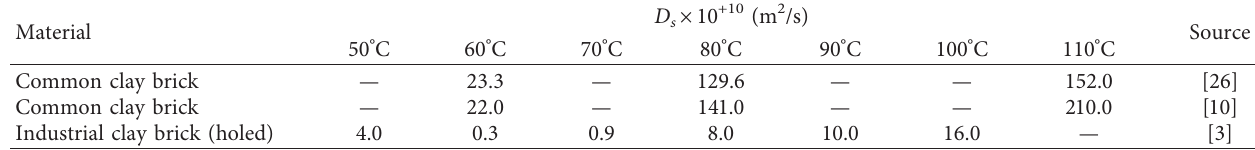
Table 9: Mass diffusion coefficient of clay brick at different drying conditions as reported in the literature.